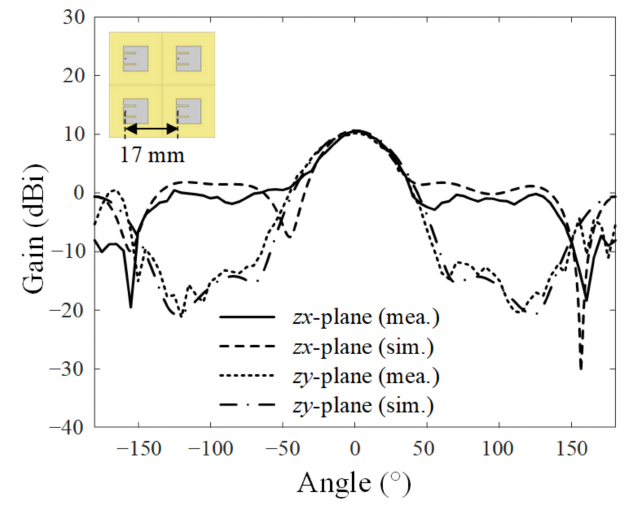
Figure 10. Array beam patterns of the 2 × 2 X-band